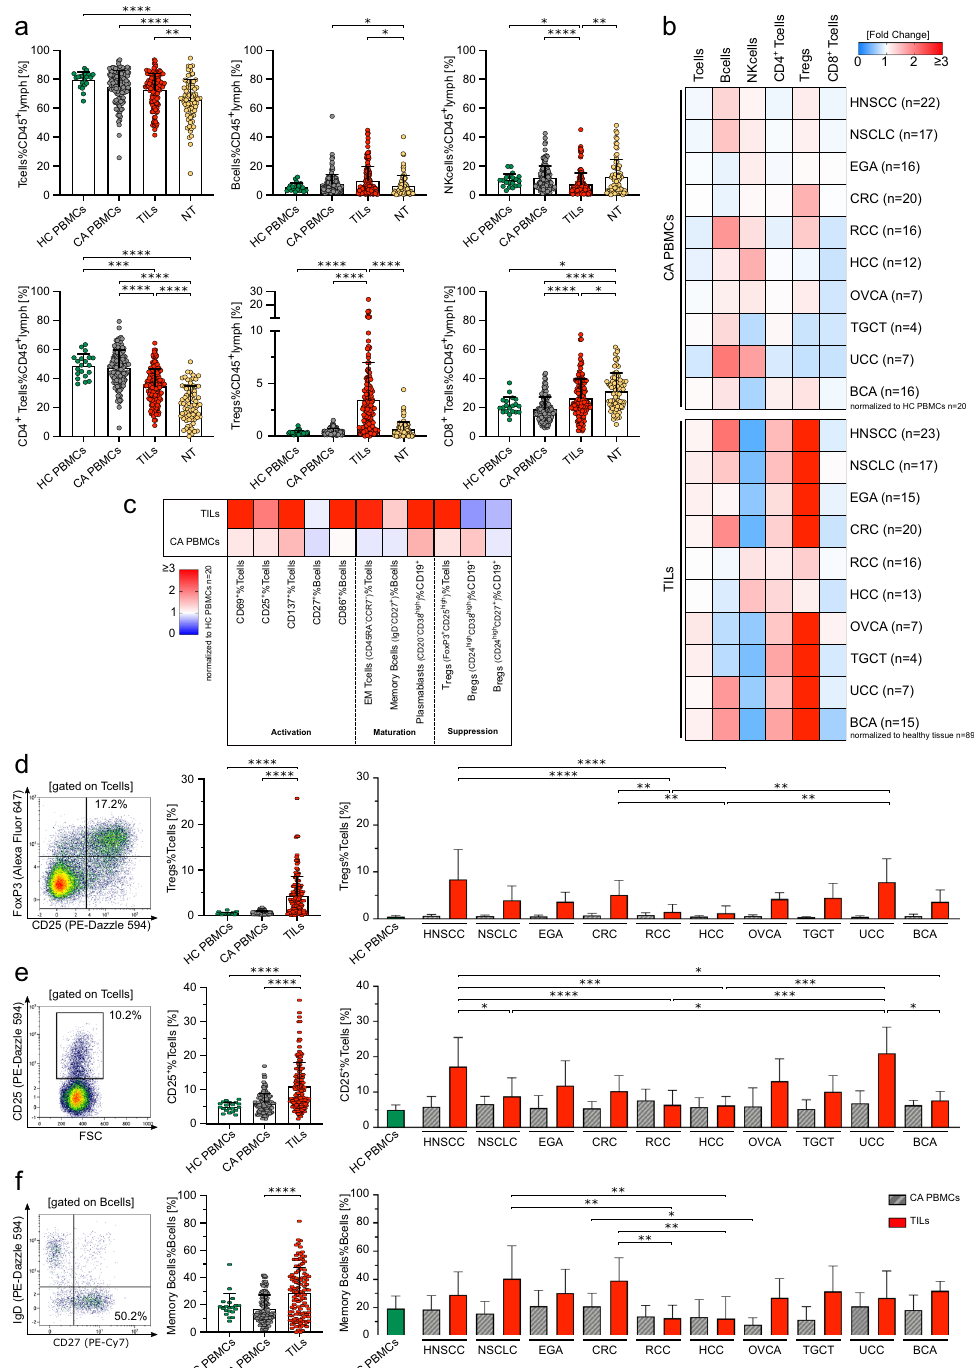
Fig. 1 In fi ltration by regulatory T cells is the most common feature across different cancer types while other lymphocyte subsets show cancer-dependent variation. a Lymphocyte subset in percent of CD45 + in healthy control PBMCs (HC PBMCs, n = 20), cancer PBMCs